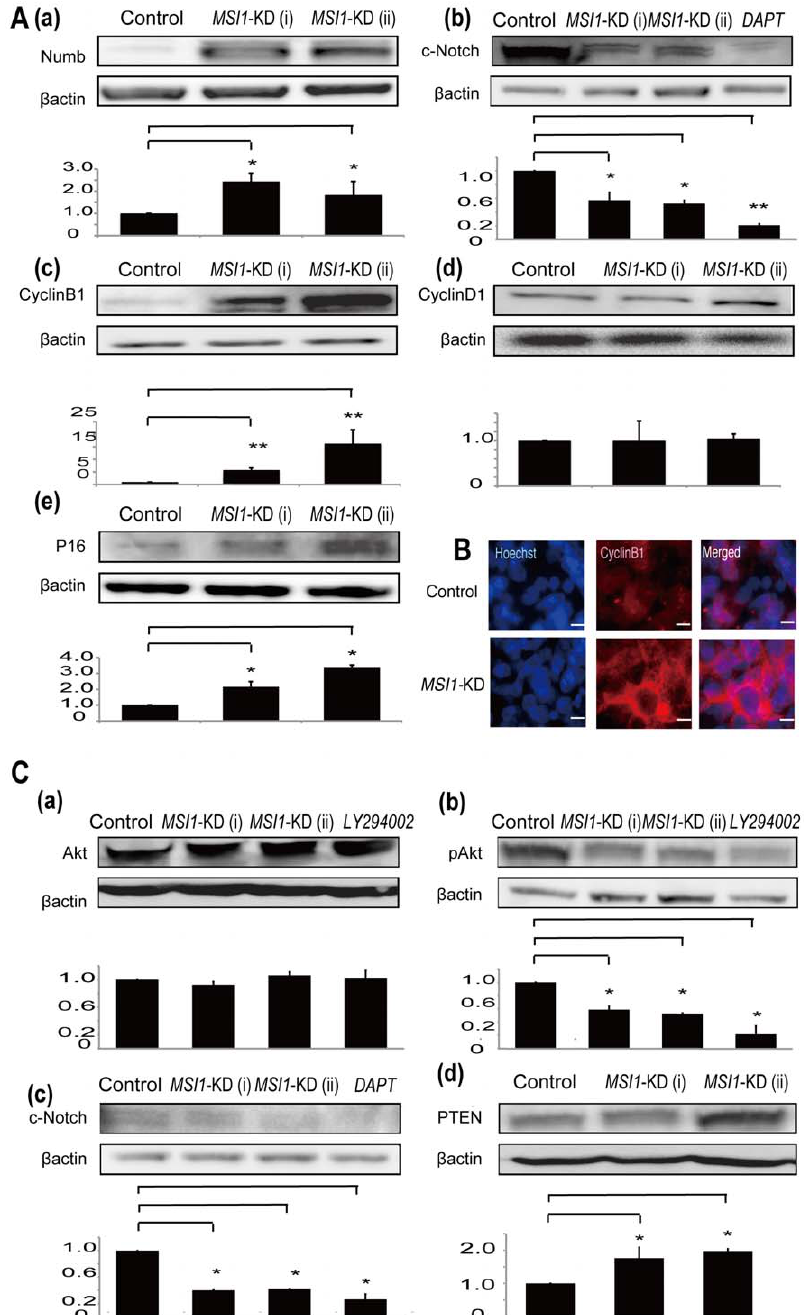
Figure 6. MSI1- KD changed the expression level of various genes. (A) Immunoblots showing the expression of various cell-cycle markers and downstream genes of MSI1 in control and MSI1 -KD in U251MG cell lines. MSI1 -KD resulted in the up-regulation of Numb, Cyclin B1, and P16, the downregulation of cleaved Notch, and no change in CyclinD1. (B) Immunocytochemistry showed that Cyclin B1 was potently expressed in MSI1 -KD cells compared with control cells. (Bar=200 m m). (C) In PTEN-intact Daoy cells, the immunoblot analysis showed that MSI1-KD led to the up- regulation of PTEN, and down-regulation of cleaved Notch and p-Akt with no change in total Akt level. Error bars represent SEM (*P , 0.01).